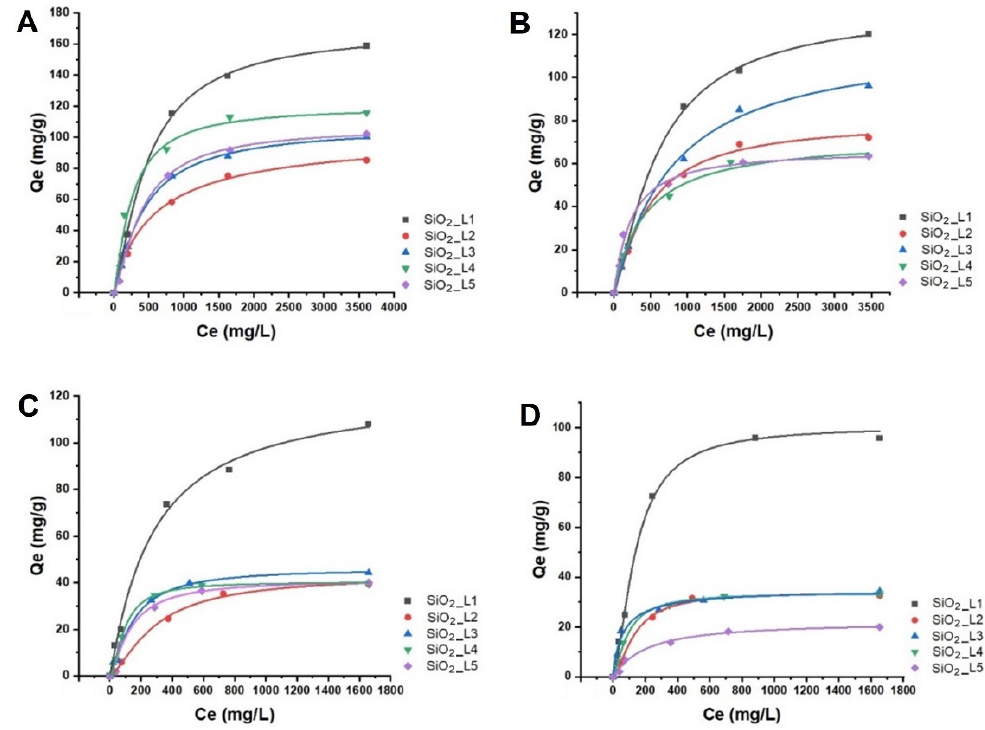
Figure 5. Langmuir adsorption isotherms of ( A ) Sm, ( B ) Nd, ( C ) Co and ( D ) Ni ions onto functionalized silica nanoparticles. Table 2. Maximum adsorption capacities of grafted SiO 2 NPs towards REEs and LTM.